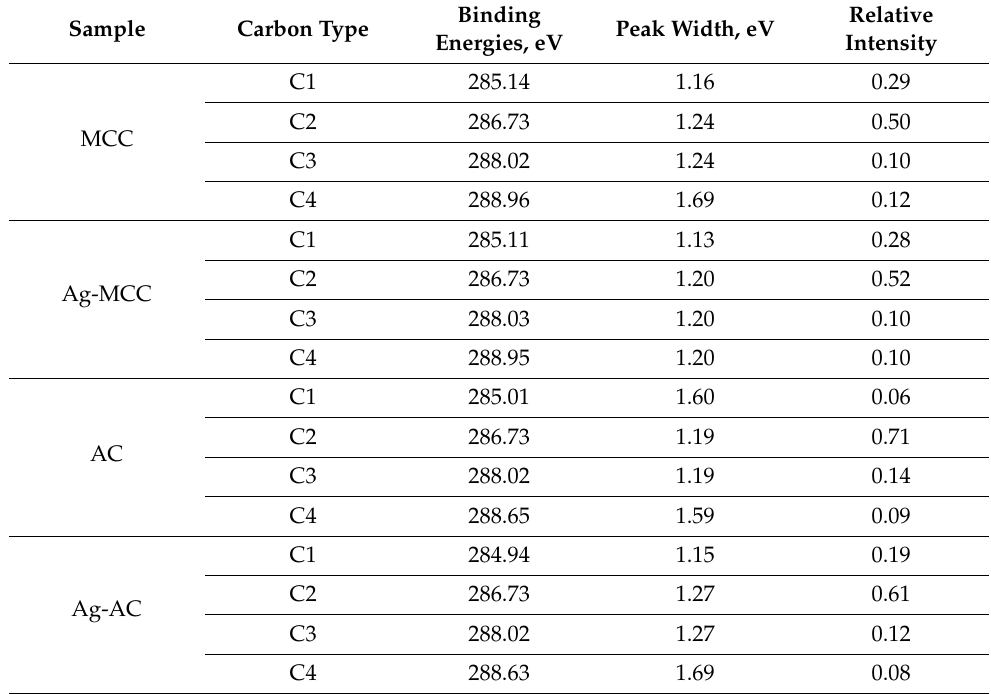
Table 6. Characteristics of Gaussian peaks in the C 1s